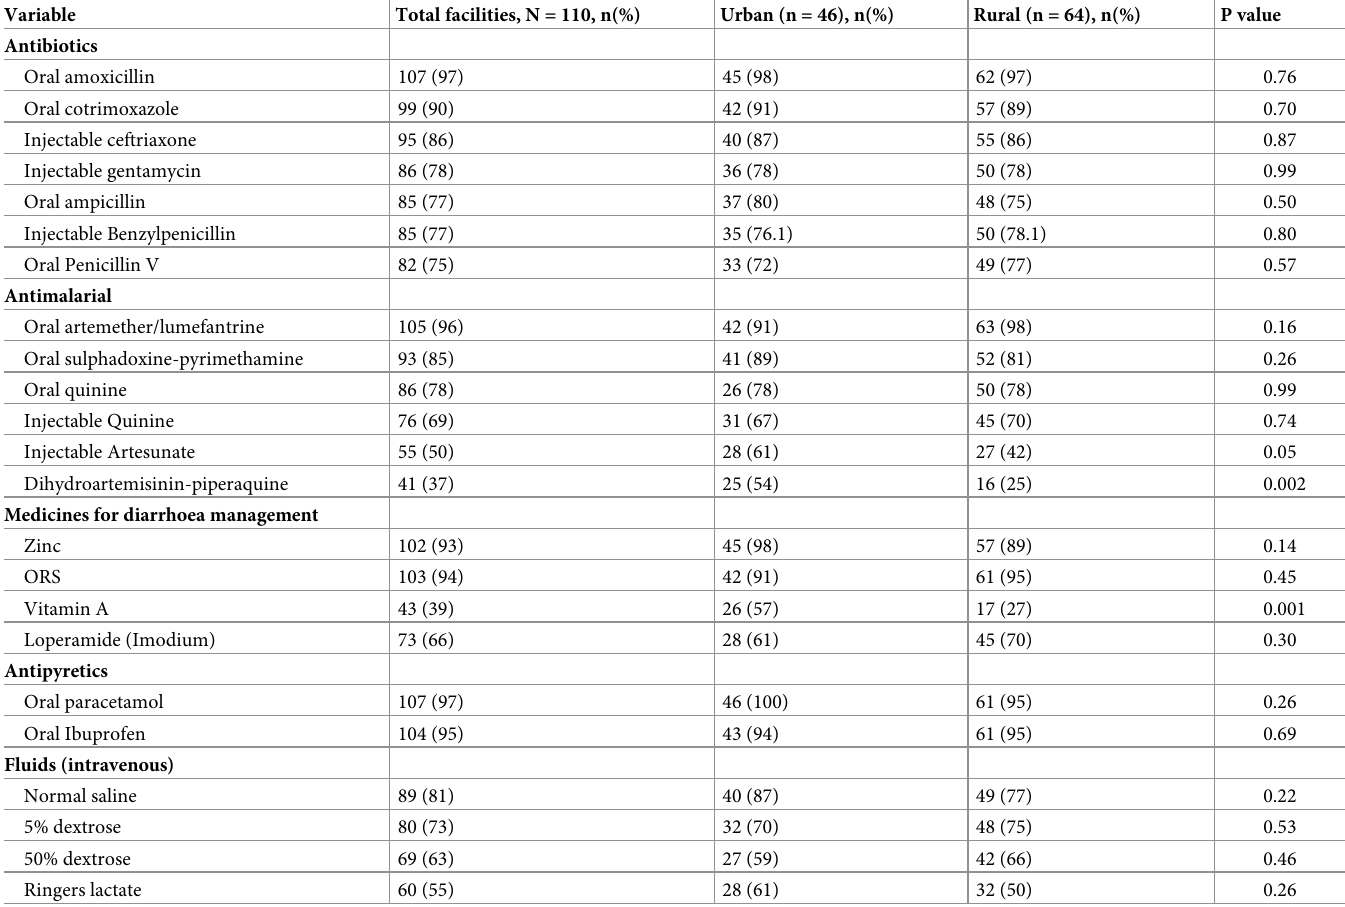
Table 3. Availability of medicines in LLPHFs in Mbarara district, Uganda by location of the health facility.